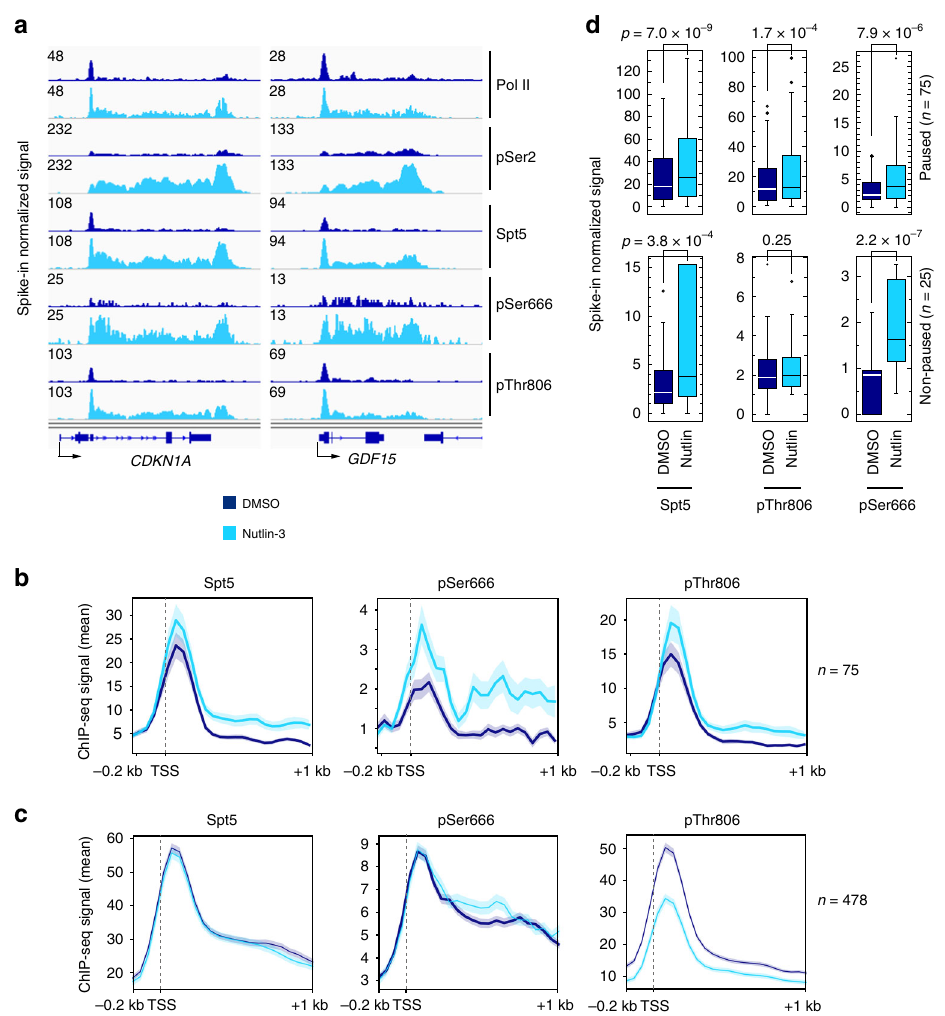
Fig. 5 pSer666 increases downstream of TSS and persists beyond CPS of p53-induced genes. a Individual ChIP-seq gene tracks at CDKN1A and GDF15 — two p53 targets — in HCT116 cells mock treated (DMSO) or treated with 5 μ M nutlin-3 for 2 h. b Metagene analysis of Spt5, Spt5-pSer666, and Spt5- pThr806 at genes induced by nutlin-3 ( n = 75; paused genes). c Same as b , but on genes selected for highest Pol II occupancy in DMSO-treated condition, and lack of induction by nutlin-3 ( n = 478). The shaded area represents standard deviation (±s.d.) from the mean distribution (solid line) ( b and c ). d Box plots comparing ChIP-seq reads in fi rst 100-nt interval downstream of TSS, in the absence or presence of nutlin-3, for Spt5, Spt5-pThr806, and Spt5- pSer666 at genes induced by nutlin-3, divided into those classi fi ed as pause-regulated (pause index ≥ 2.0, n = 75) or nonpaused (pause index < 2.0, n = 25). Indicated p values were calculated using two-sided Student ’ s t test. Source data are provided as a Source data